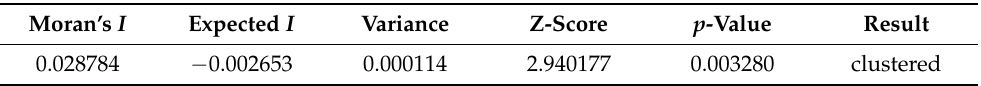
Table 1. Result of the spatial autocorrelation test on ASFV cases in mainland of China, from 1 August 2018 to 31 August